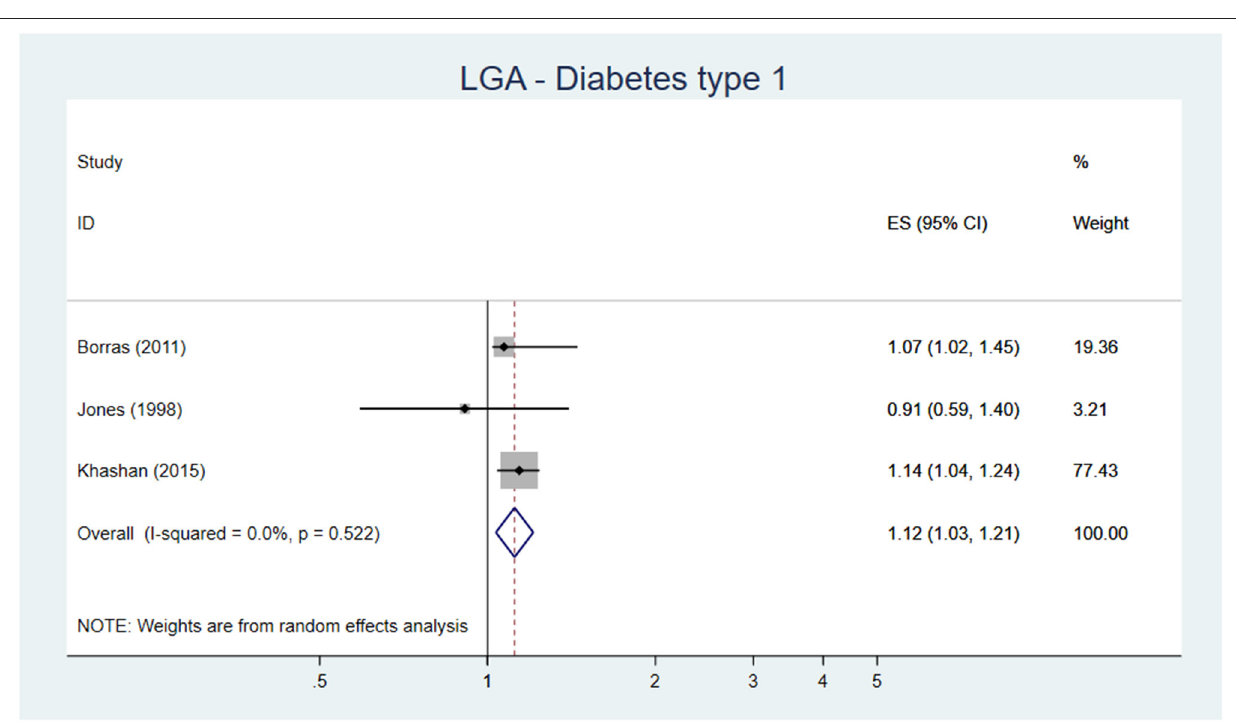
FIGURE 10 | Forest plot describing the association between LGA and Diabetes type